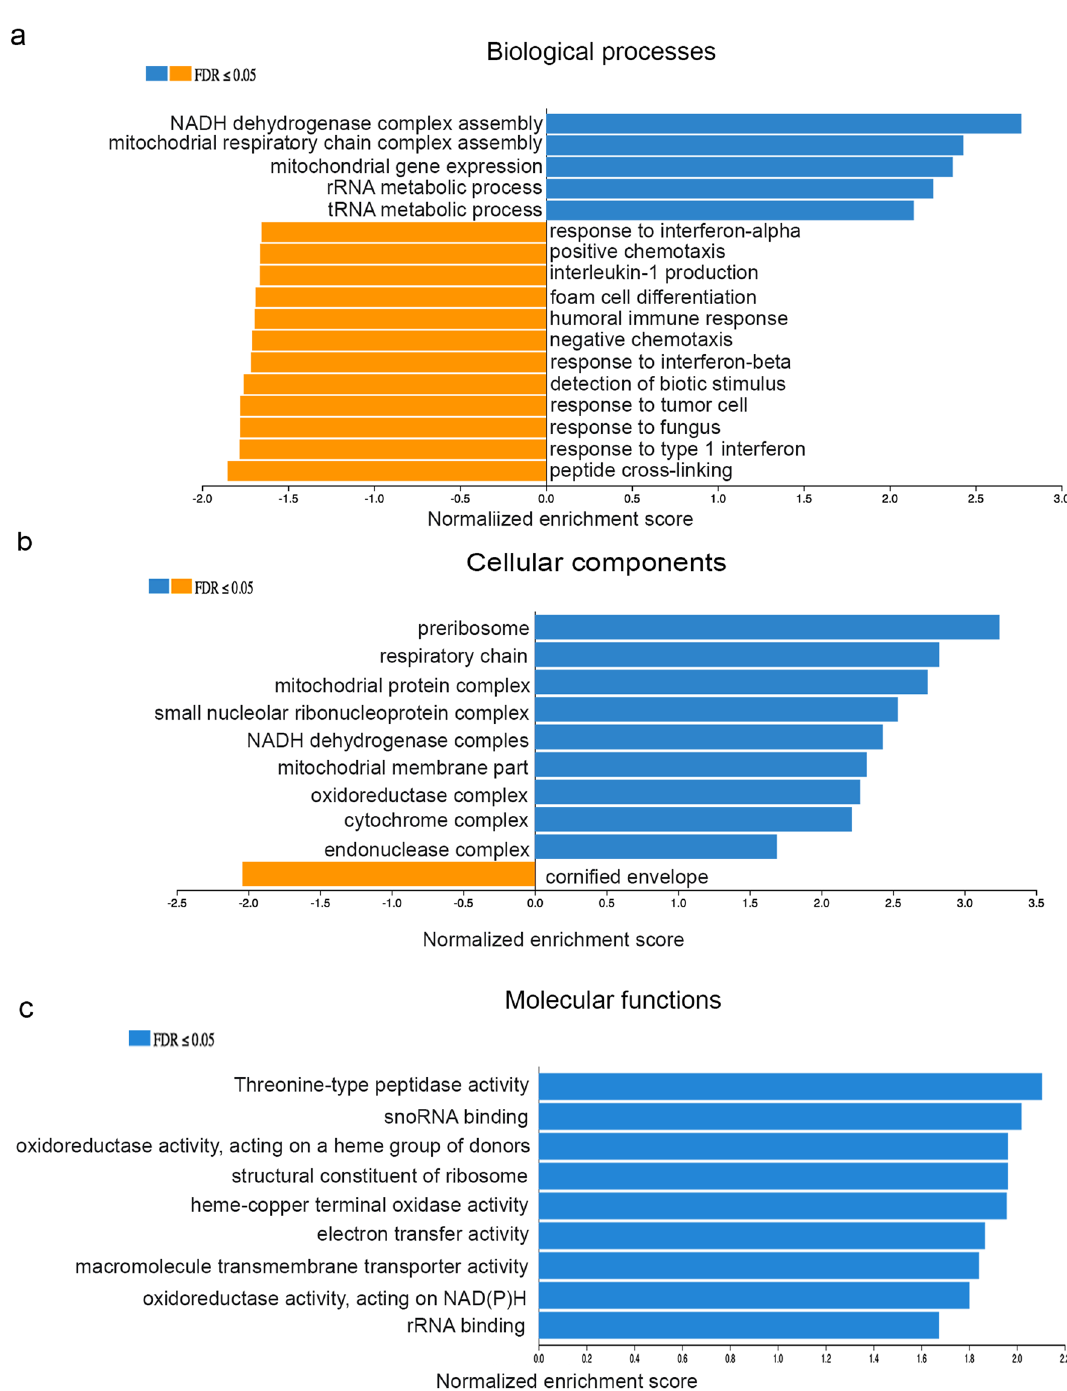
Figure 6. Gene ontology enrichments for OLFM4 -knockout GFP reporter RWPE1 cells. ( a ) Bar graph presents upregulated (blue; FDR ≤ 0.05) and downregulated (orange; FDR ≤ 0.05) pathways for biological processes using WebGestalt 2019. ( b ) Bar graph presents upregulated (blue; FDR ≤ 0.05) and downregulated (orange; FDR ≤ 0.05) pathways for cellular components. ( c ) Bar graph presents upregulated (blue; FDR ≤ 0.05) pathways for molecular